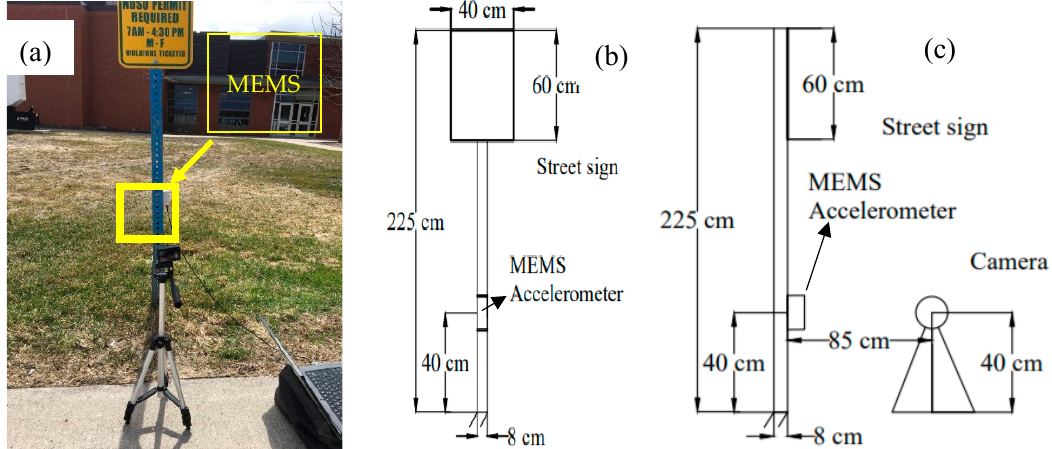
Figure 10. Setup of street sign experiment: ( a ) Field photo, ( b ) Front view with dimensions, ( c ) Side view with dimensions.